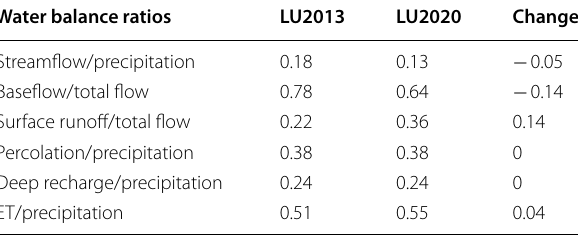
Table 7 Changes in the water balance ratios under